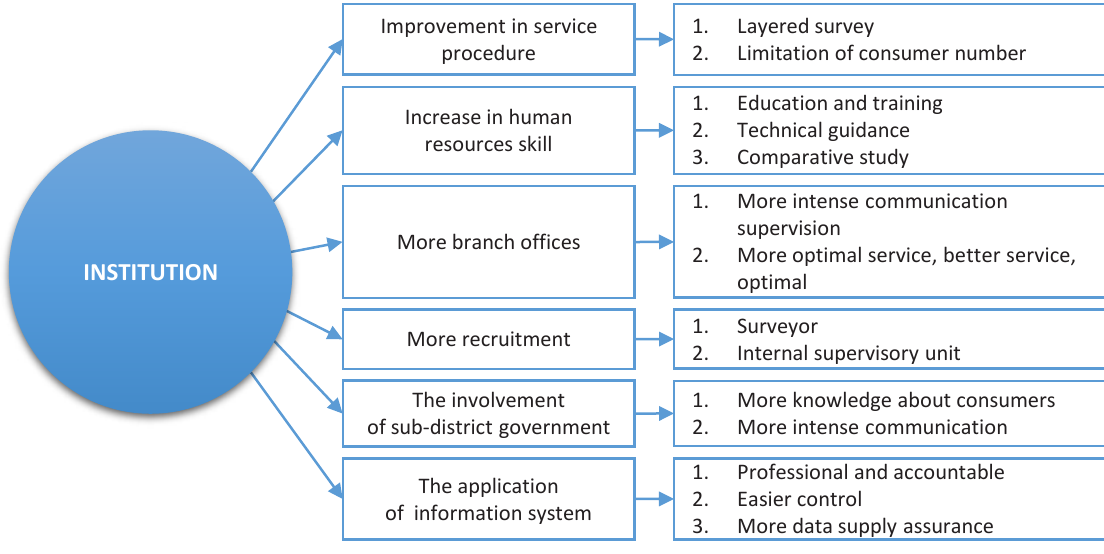
Figure 3. Strategies to improve performance of “Harum” microcredit institution in Kendari